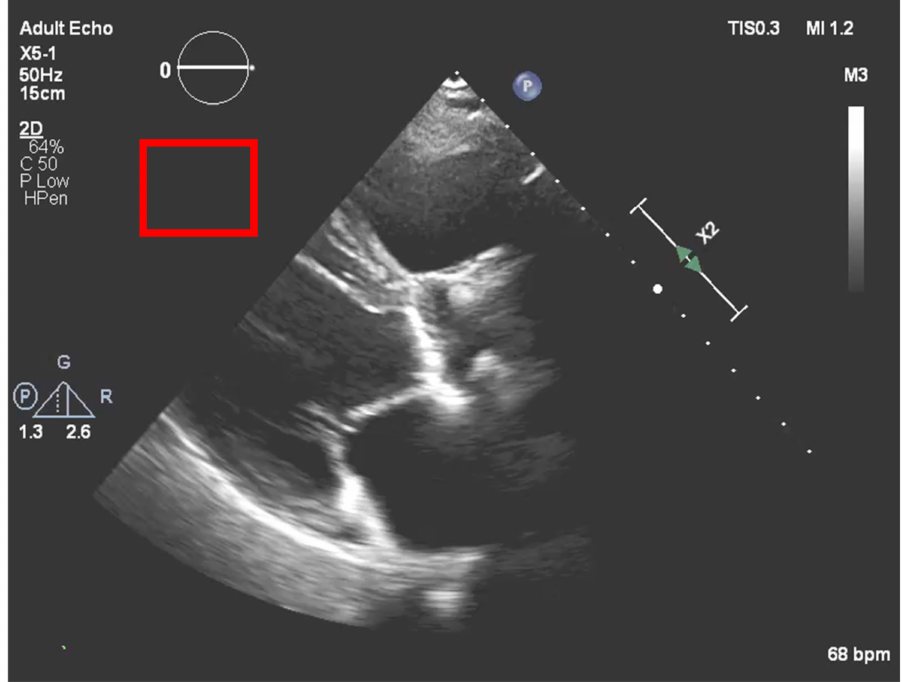
Figure 7. Normalization region of interest (red square) to compensate the post image